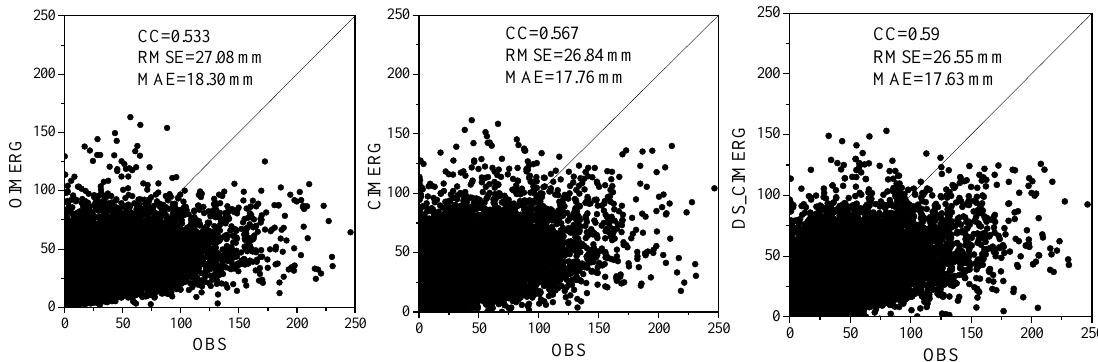
Figure 15. Scatter diagrams of OIMERG, CIMERG, and DS_CIMERG against the observed precipitation during the warm seasons from 2010 to 2018.